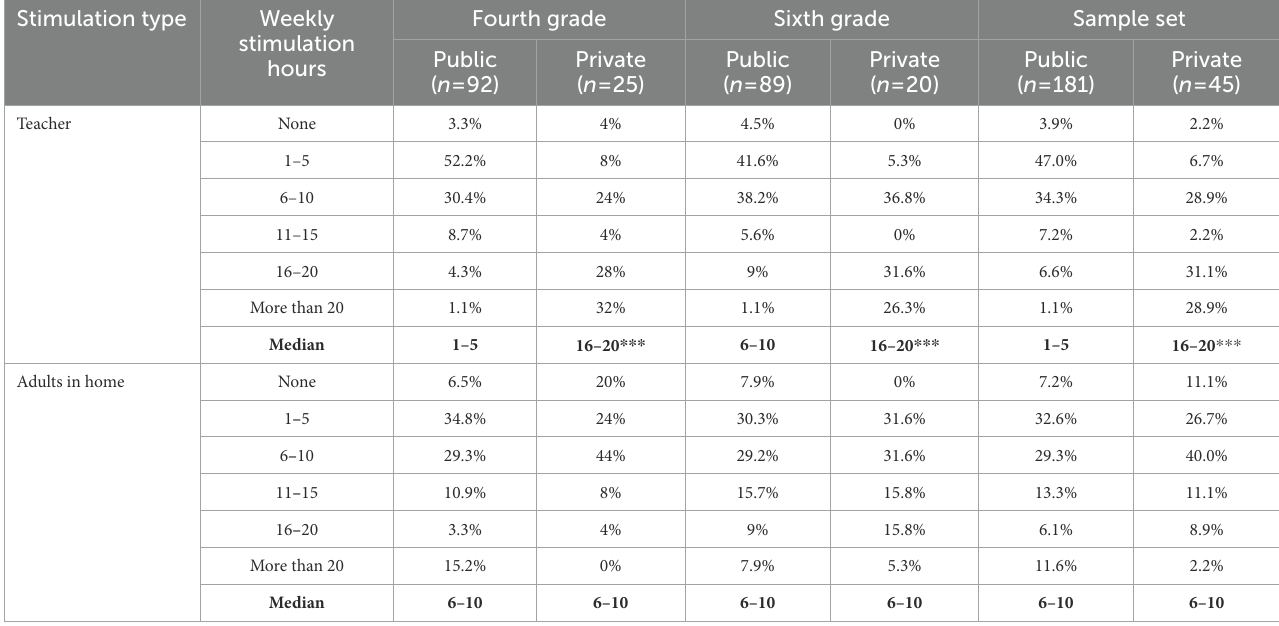
TABLE 7 Relative and median frequency of academic stimulation time by the teacher and adults at home, by type of schooling and grade. Stimulation